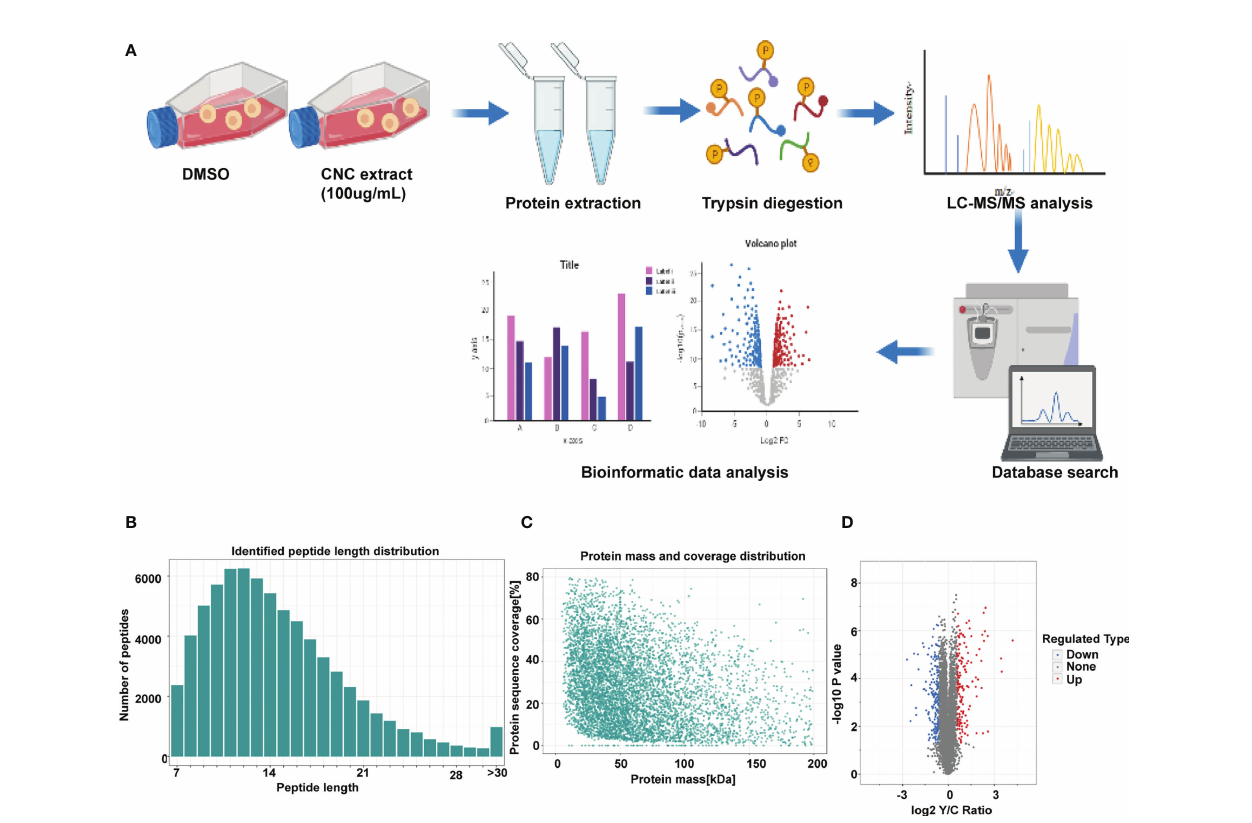
FIGURE 3 | Differentially expressed proteins were evaluated by proteomics. (A) Flow diagram of 4D Label-free proteomics. (B) Length distribution of the peptides identi fi ed by mass spectrometry. (C) Relationship between protein molecular weight and coverage. (D) Volcano plot of differentially expressed proteins. The blue dots are down-regulated proteins. The red dots are up-regulated proteins. There were three duplicate samples in each